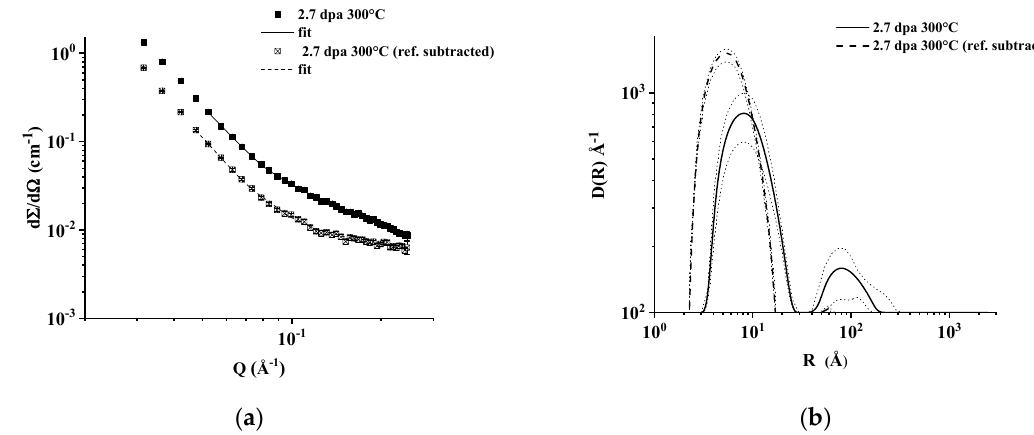
Figure 6. Eurofer97 neutron irradiated to 2.7 dpa at 300 °C: ( a ) best fits to nuclear SANS cross-section without (full squares) and with (empty squares) subtraction of the reference sample’s cross-section, ( b ) best-fit micro-void distributions (Å -1 ) obtained without (continuous line) and with (dashed line) subtraction of reference sample’s cross-section. The 80% confidence bands are indicated by the dotted lines .